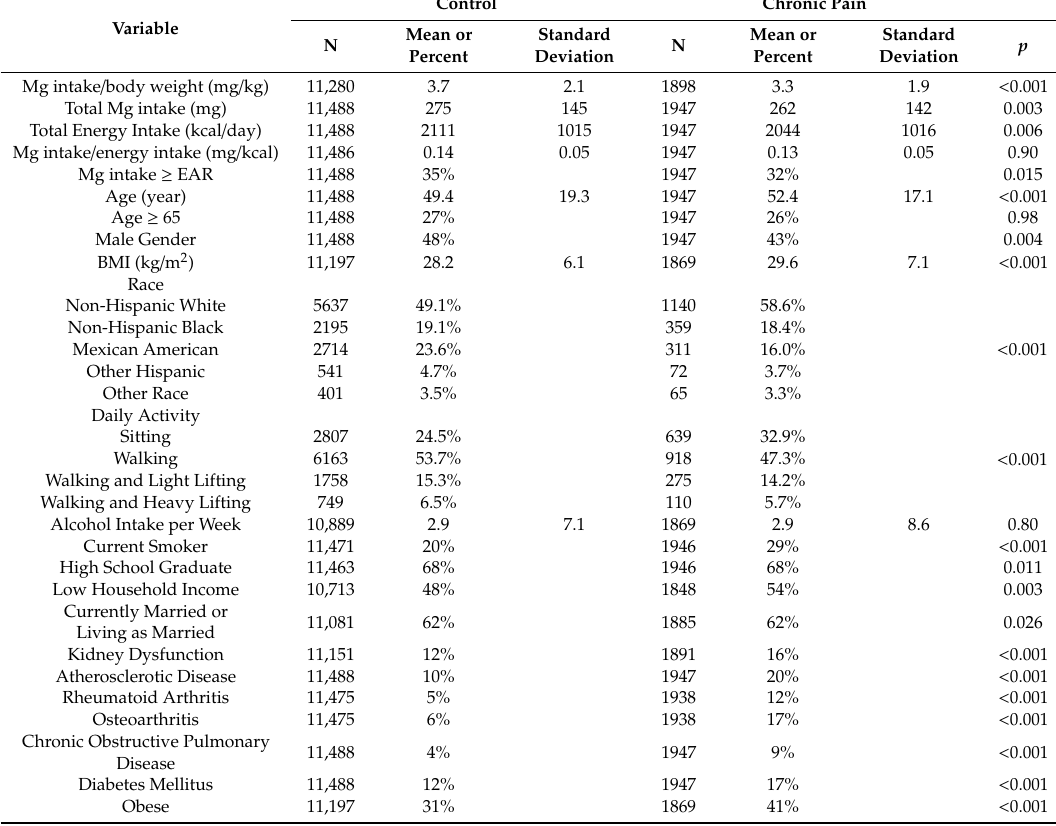
Table 1. Subject